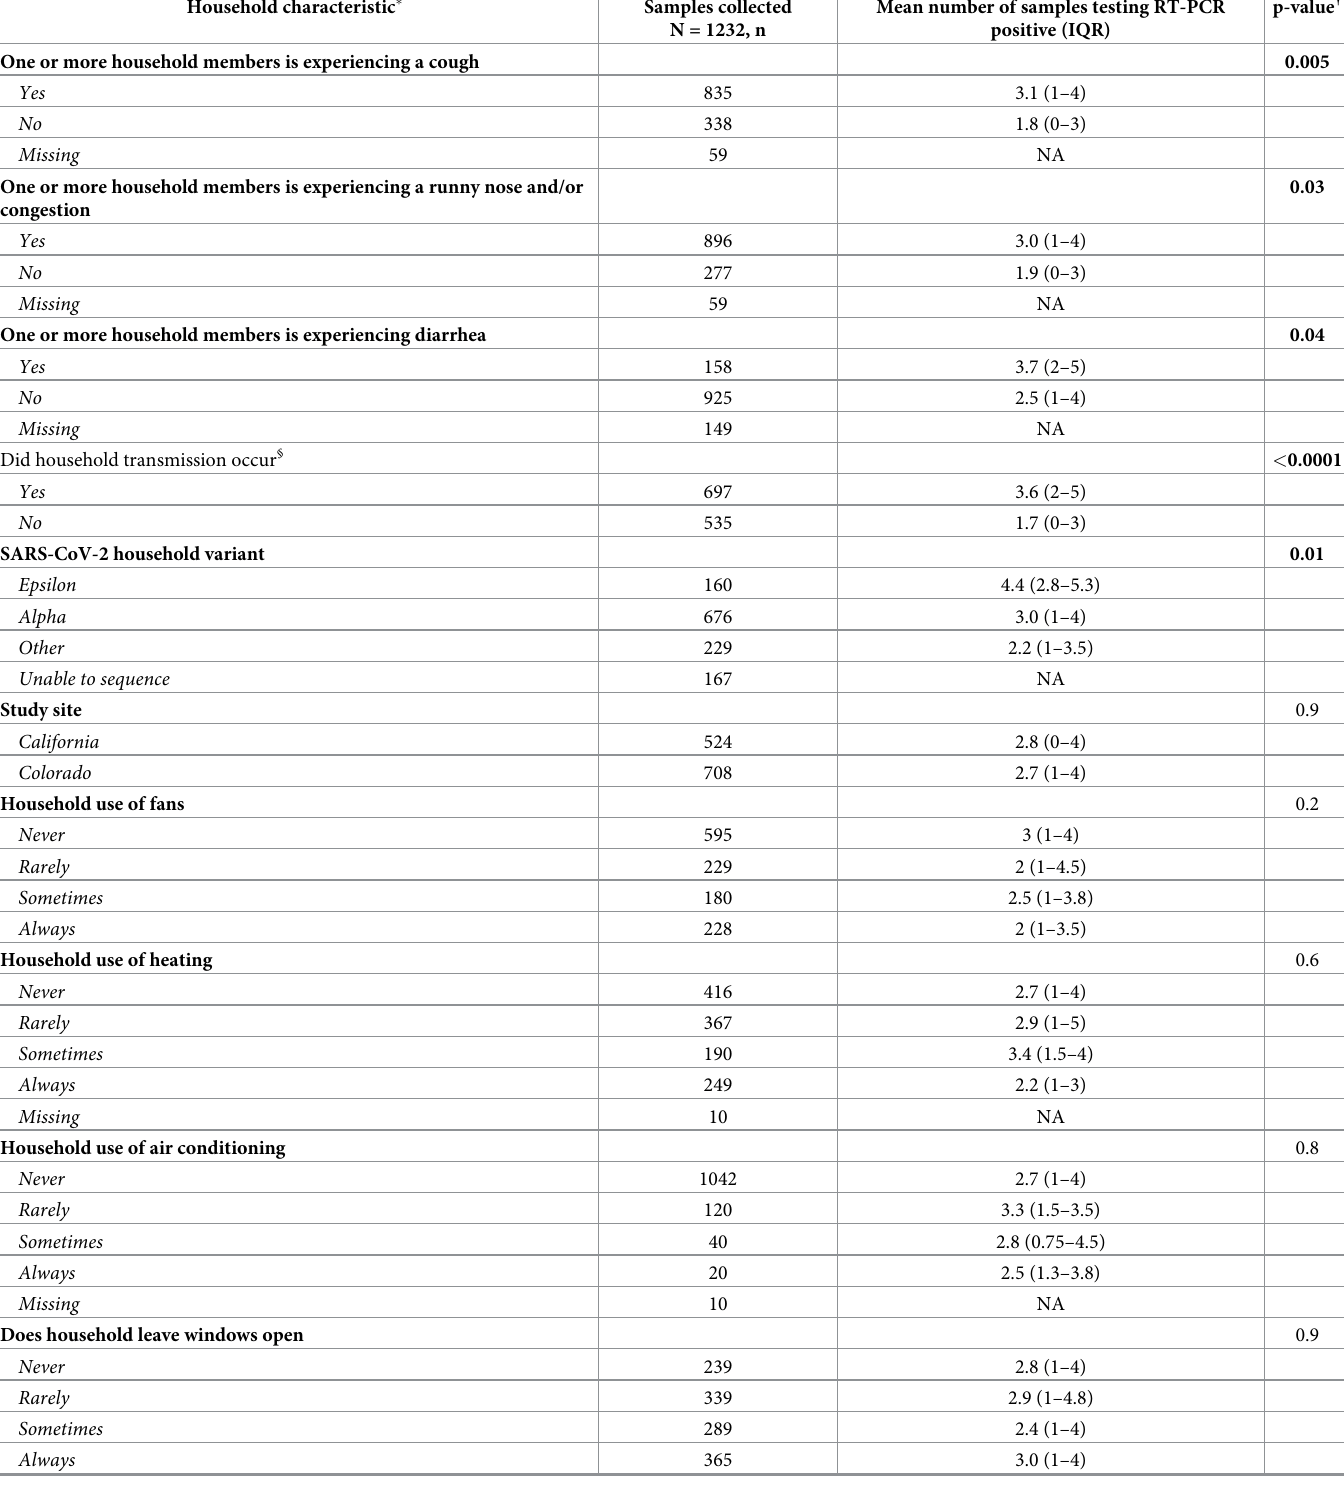
Table 3. Household characteristics, total environmental samples collected, and univariate analysis of association between categorical household characteristics and number of positive environmental